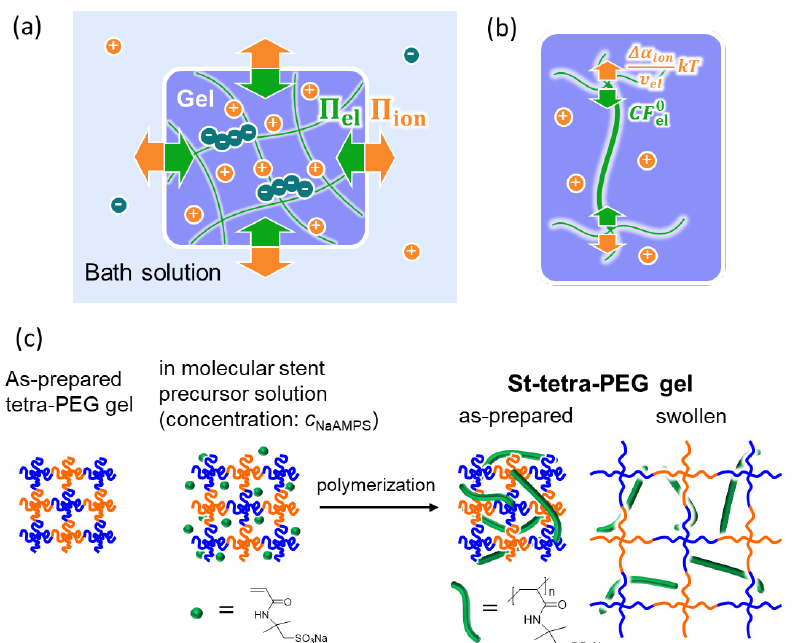
Figure 1. ( a ) Schematic illustration of the balance between the elastic pressure (symbolically expressed by green arrows) and ionic osmotic pressure (orange arrows) of a highly swollen charged gel at swelling equilibrium, where + and – are cations and anions, respectively; ( b ) balance between elasticity and ionic osmosis at a single-strand level; and ( c ) the synthesis pathway of the St-tetra-PEG gels used in this work.